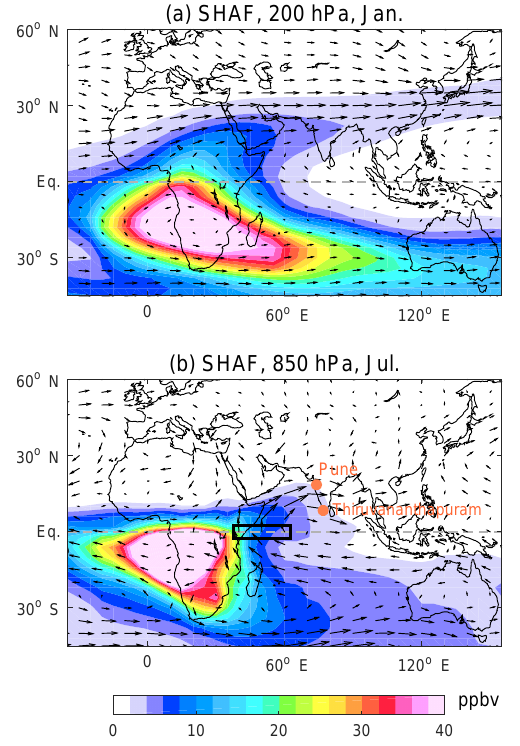
Figure 16. Distributions of ozone from SHAF (in ppbv, in color), overlaid with winds (shown by arrows), at (a) 200hPa in January and (b) at 850hPa in July. The ozone values are the means from the 20-year GEOS-Chem simulation. The black rectangle indicates the domain used in calculating the strength of the Somali cross- equatorial flow. The brown dots indicate the ozonesonde sites in western India.